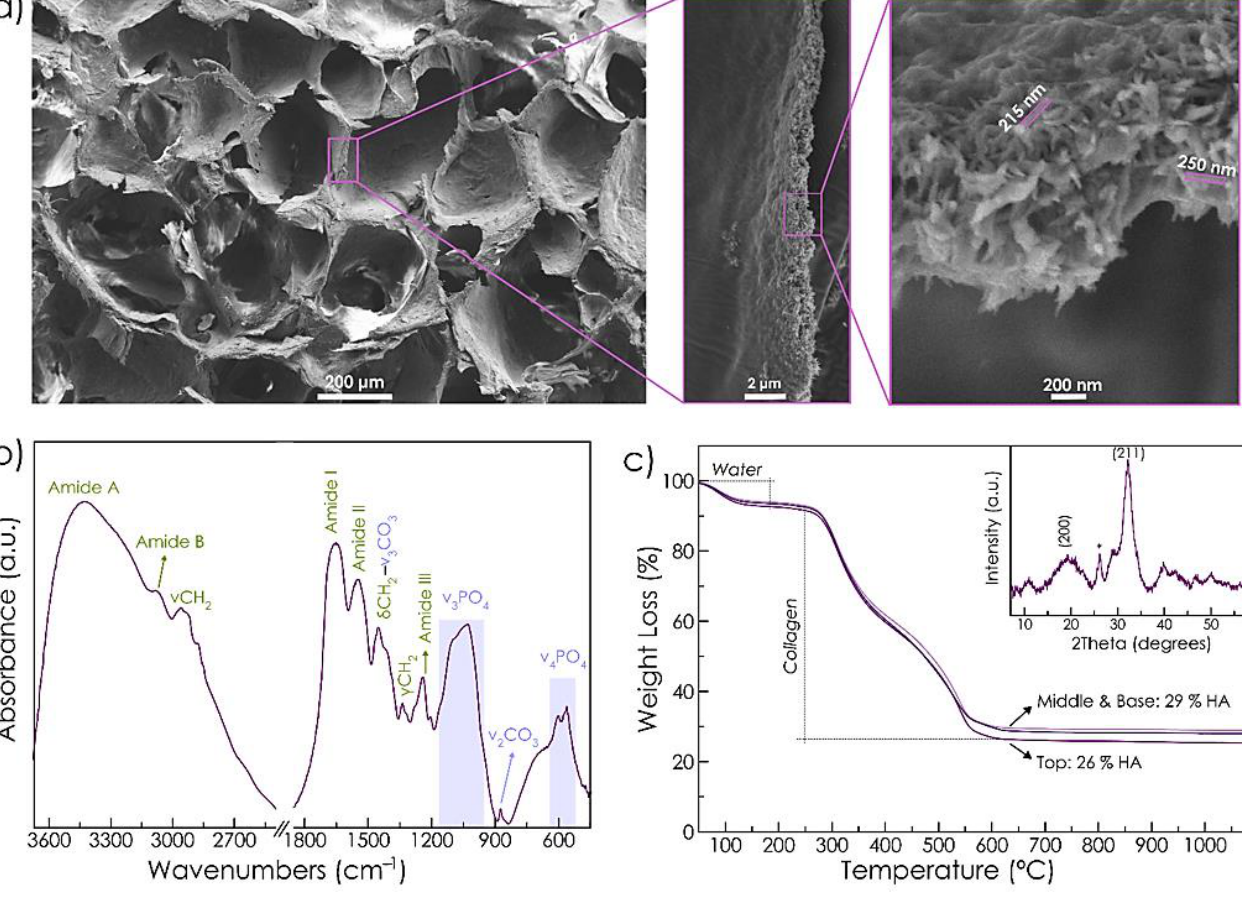
Figure 3. ( a ) SEM images of cross-section of RCP.MgAp scaffold. High magnification image of the wall of the pores shows the incorporation of Ap into the organic matrix. ( b ) Fourier-transform infrared spectroscopy (FTIR) spectrum of RCP.MgAp scaffold. ( c ) TGA curve of the top, middle and base of the scaffold. Inset displays X-ray diffraction (XRD) pattern of the sample exhibiting characteristic reflections of hydroxyapatite (HA, ASTM card file No 09-432).